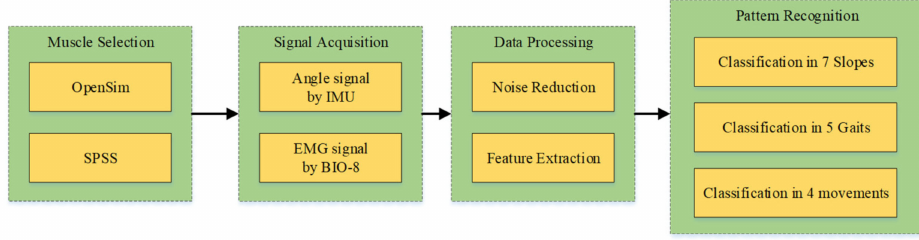
Figure 1. Research process in this